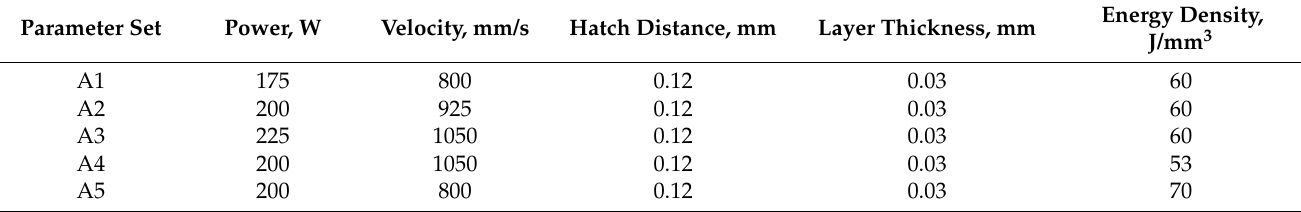
Table 1. Parameter sets of sample preparation by selective laser